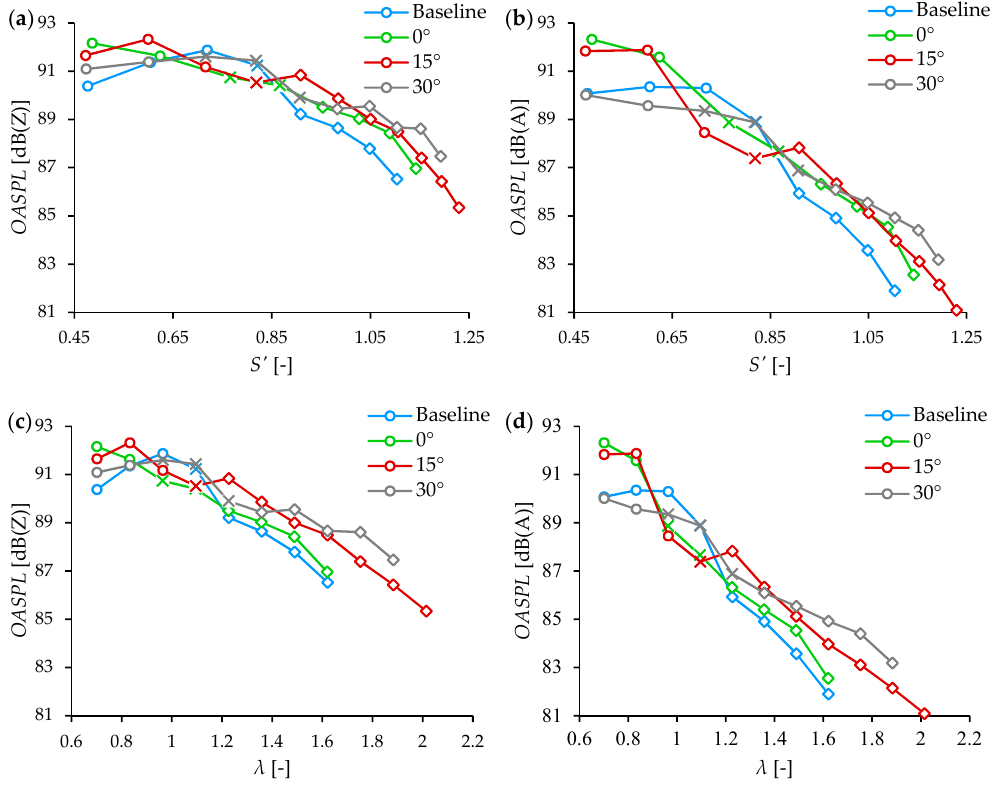
Figure 6. ( a , c ) OASPL with Z- and ( b , d ) A-weighting functions using the baseline burner and various Figure 6 . ( a ), ( c ) OASPL with Z- and ( b ), ( d ) A-weighting functions using the baseline burner and quarls as a function of S ’ ( a , b ) and λ ( c , d ) all at p g = 0.3 bar. Symbols: straight flame ( ◦ ), transitory various quarls as a function of S’ ( a ) and ( b ) and λ ( c ) and ( d ) all at p g = 0.3 bar. Symbols: straight flame flame ( × ), and V-shaped flame ( ♦ ( ○ ), transitory flame ( × ), and V-shaped flame ( ◊ ).